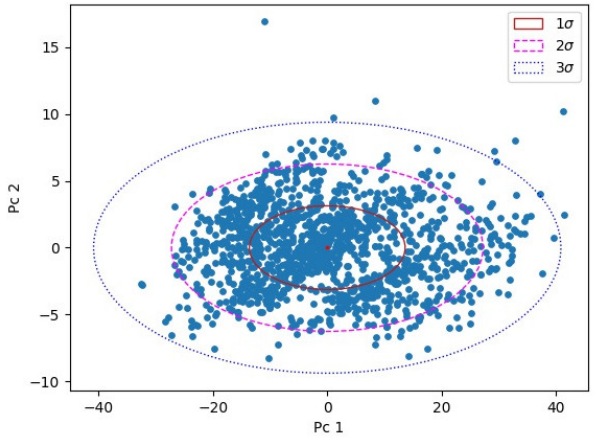
Figure 3. The first two PCs of the absorbance baseline of the training set together with confidence ellipsoids.